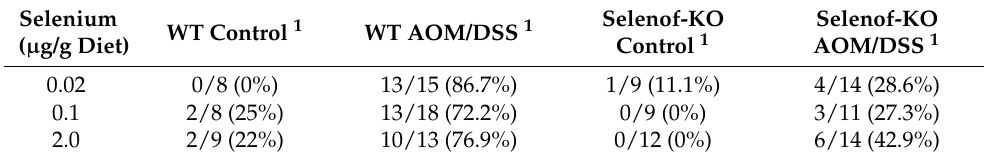
Table 1. Incidence of aberrant crypt foci in untreated (control) and AOM/DSS-treated mice.